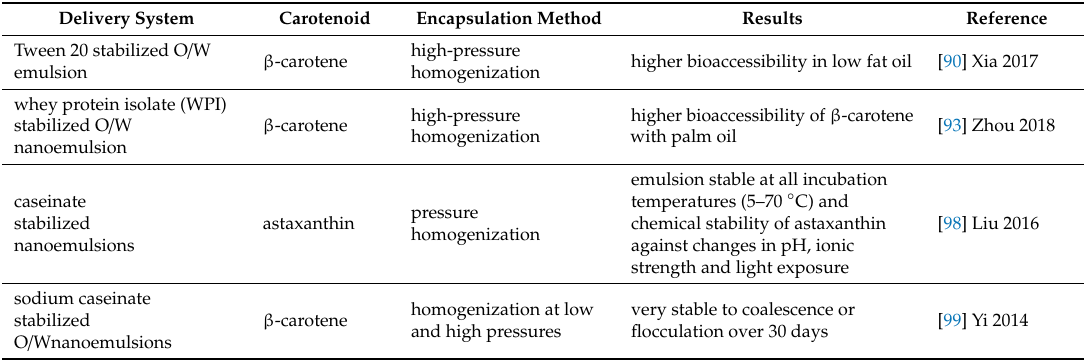
Table 3. Nanoemulsions as delivery system for carotenoid